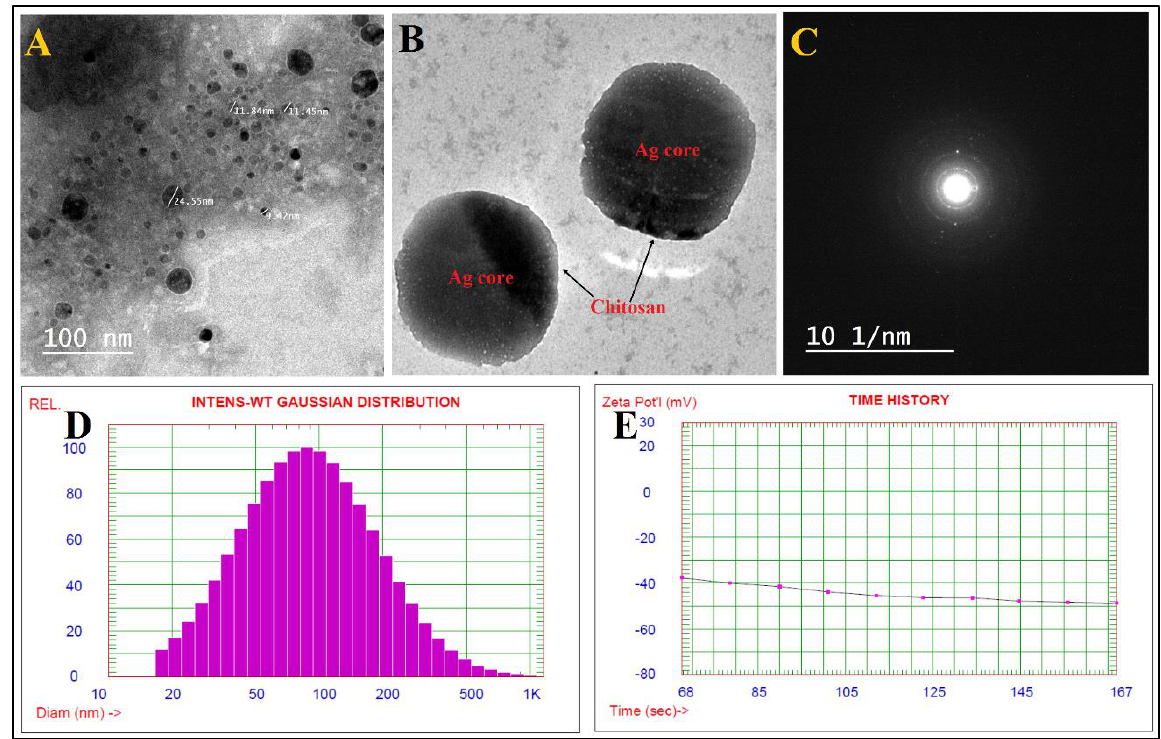
Figure 2. TEM images ( A , B ), SAED pattern ( C ), DLS ( D ) ,and zeta potential ( E ) of Chi-Ag-NPs.